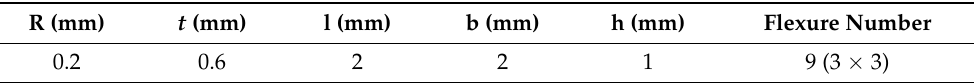
Table 1. Dimensional parameters of the flexure